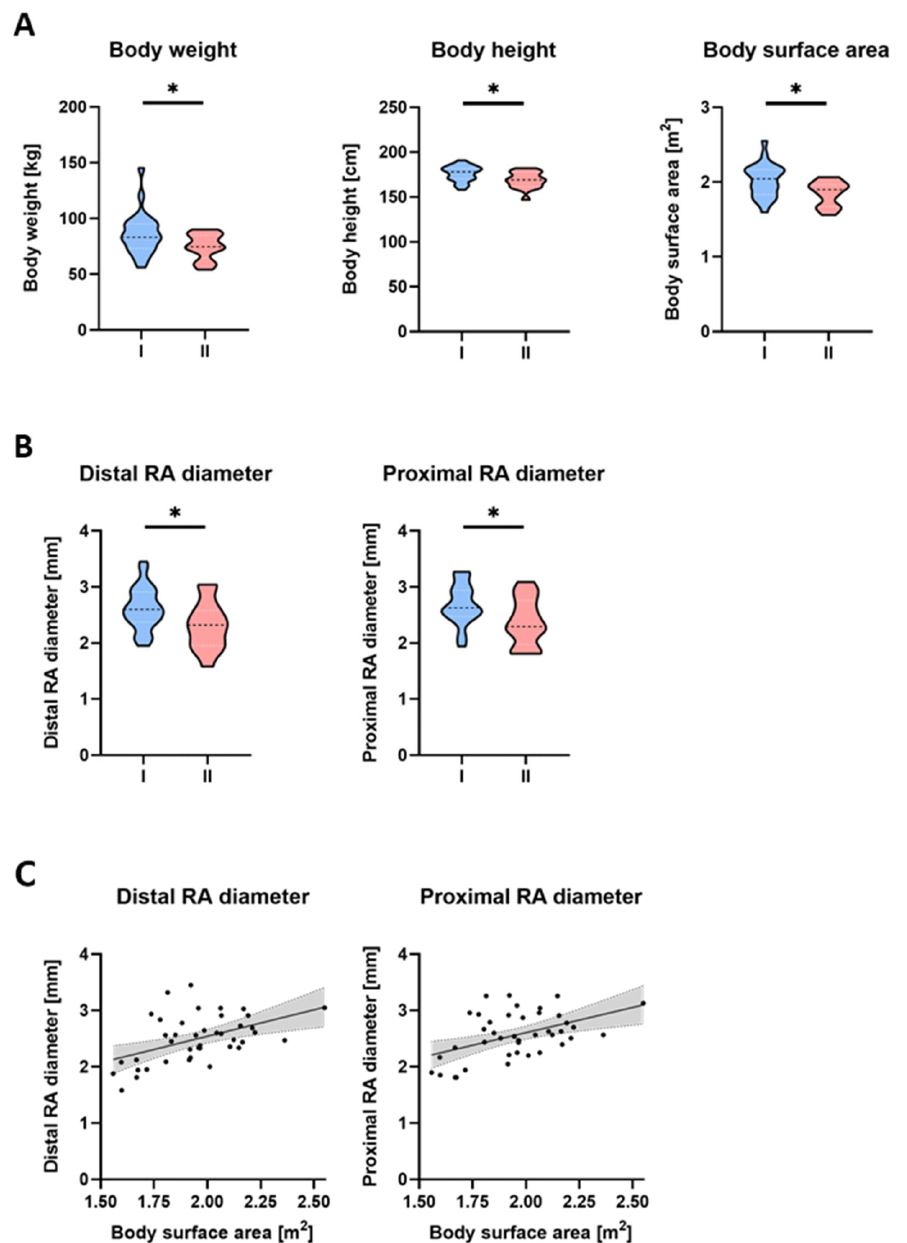
Figure 1. Body metrics and preoperative radial artery ultrasound. Ultrasound assessment of the left radial artery (RA) was performed in all patients the day before surgery using a linear probe. According to the number of attempts needed for successful subsequent RA catheterization, the cohort was divided into un-complicated and difficult (more than one attempt) catheterization (group 1 ( n = 25) or 2 ( n = 16), respectively). ( A ) Patients in group 2 (difficult catheterization) had lower body weight, height and surface area than those in group 1. ( B ) In group 2 (difficult catheterization), distal (at the level of the styloid process) and 5 cm proximal internal RA diameter was significantly smaller compared to those in group 1. ( C ) In the whole cohort, body surface area was significantly associated with distal as well as proximal internal RA diameter. Data are visualized as violin diagrams with median and interquartile range (25–75), indicated by the dashed lines. Mann-Whitney test and Spearman correlation were used for analysis. * p < 0.05.